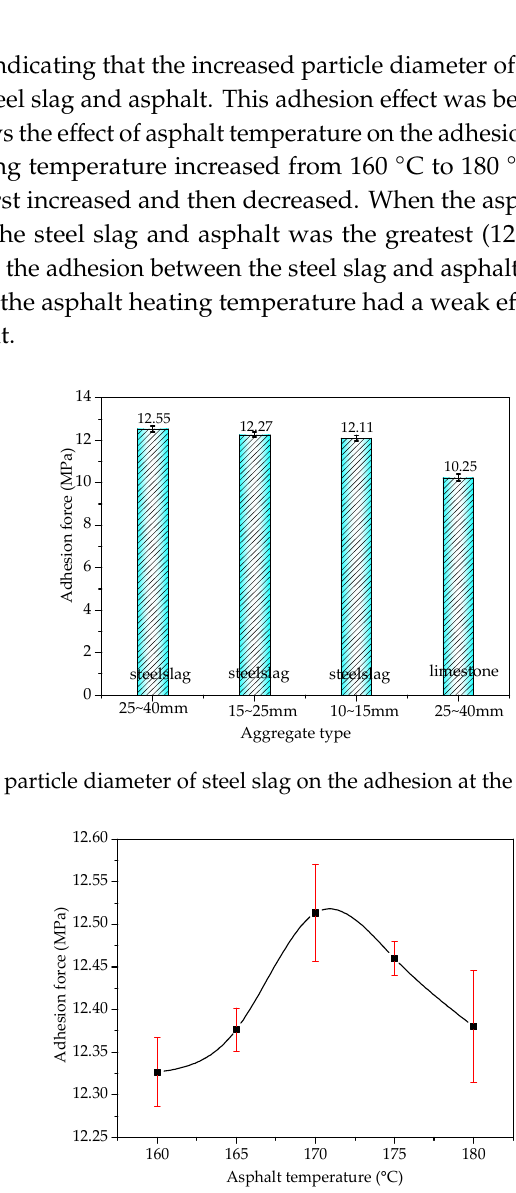
Figure 4. Effect of mixing time on the adhesion at the asphalt–steel slag interface.